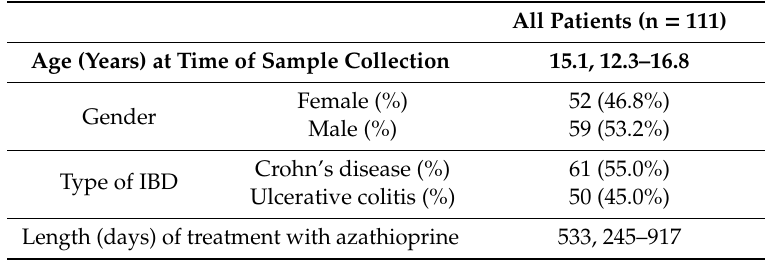
Table 2. Demographic and clinical characteristics of the patients enrolled in the study.